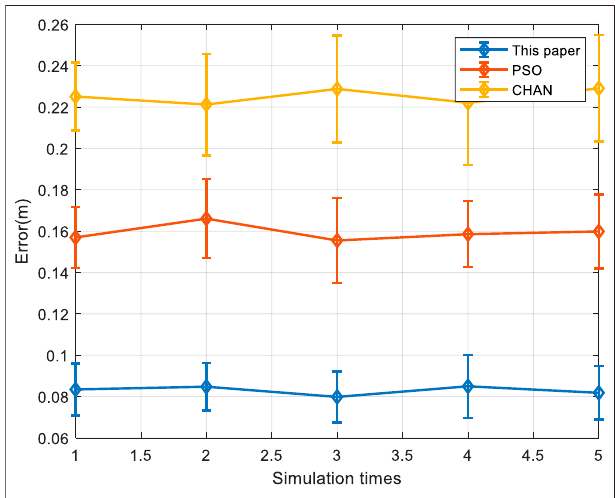
FIGURE 4 | Performance comparison of the proposed solution against the CHAN and PSO